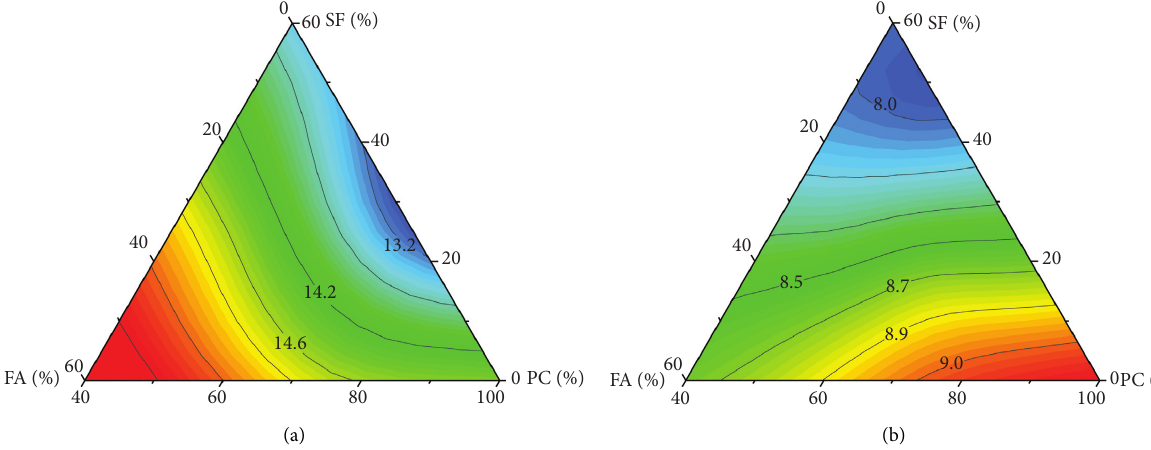
Figure 3: Effects of different cementitious composition on the porosity of UHSC: (a) 3 days and (b) 28 days.